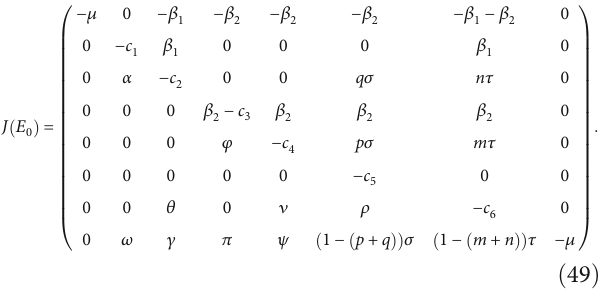
I T ) infected, COVID-19 (